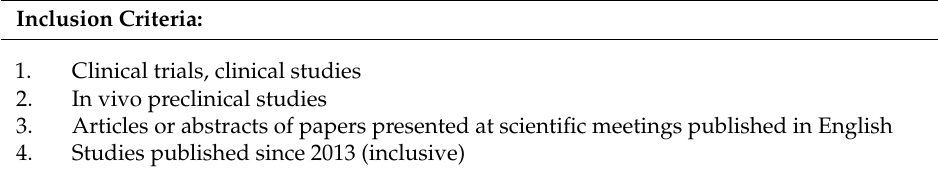
Table 1. Inclusion and exclusion criteria.